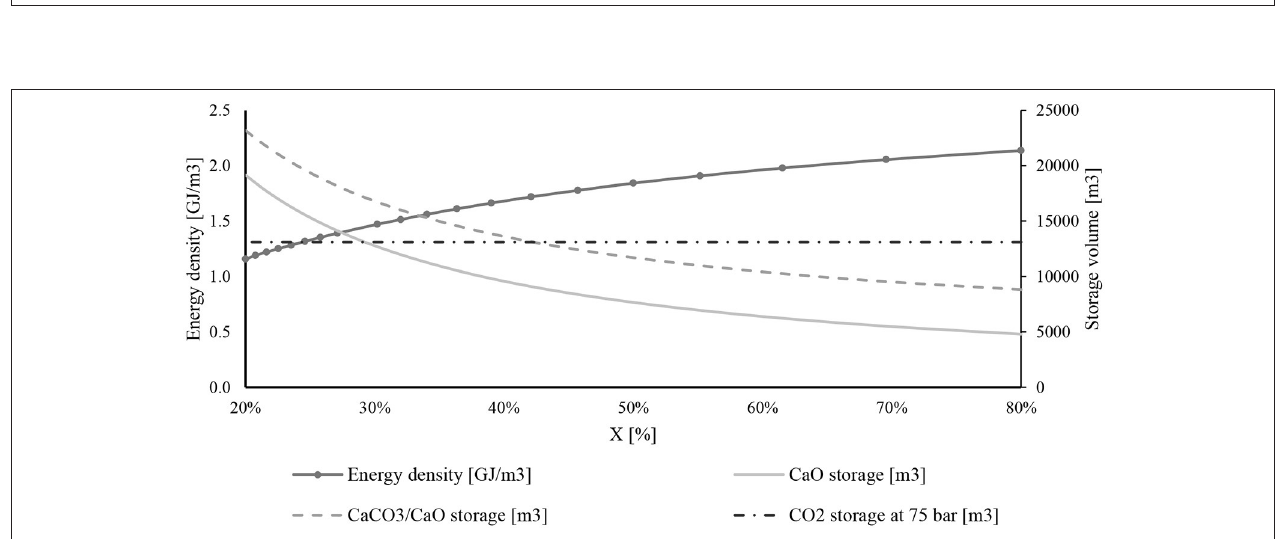
FIGURE 11 | Daily storage volume of chemical compounds and energy density with the change of CaO conversion.